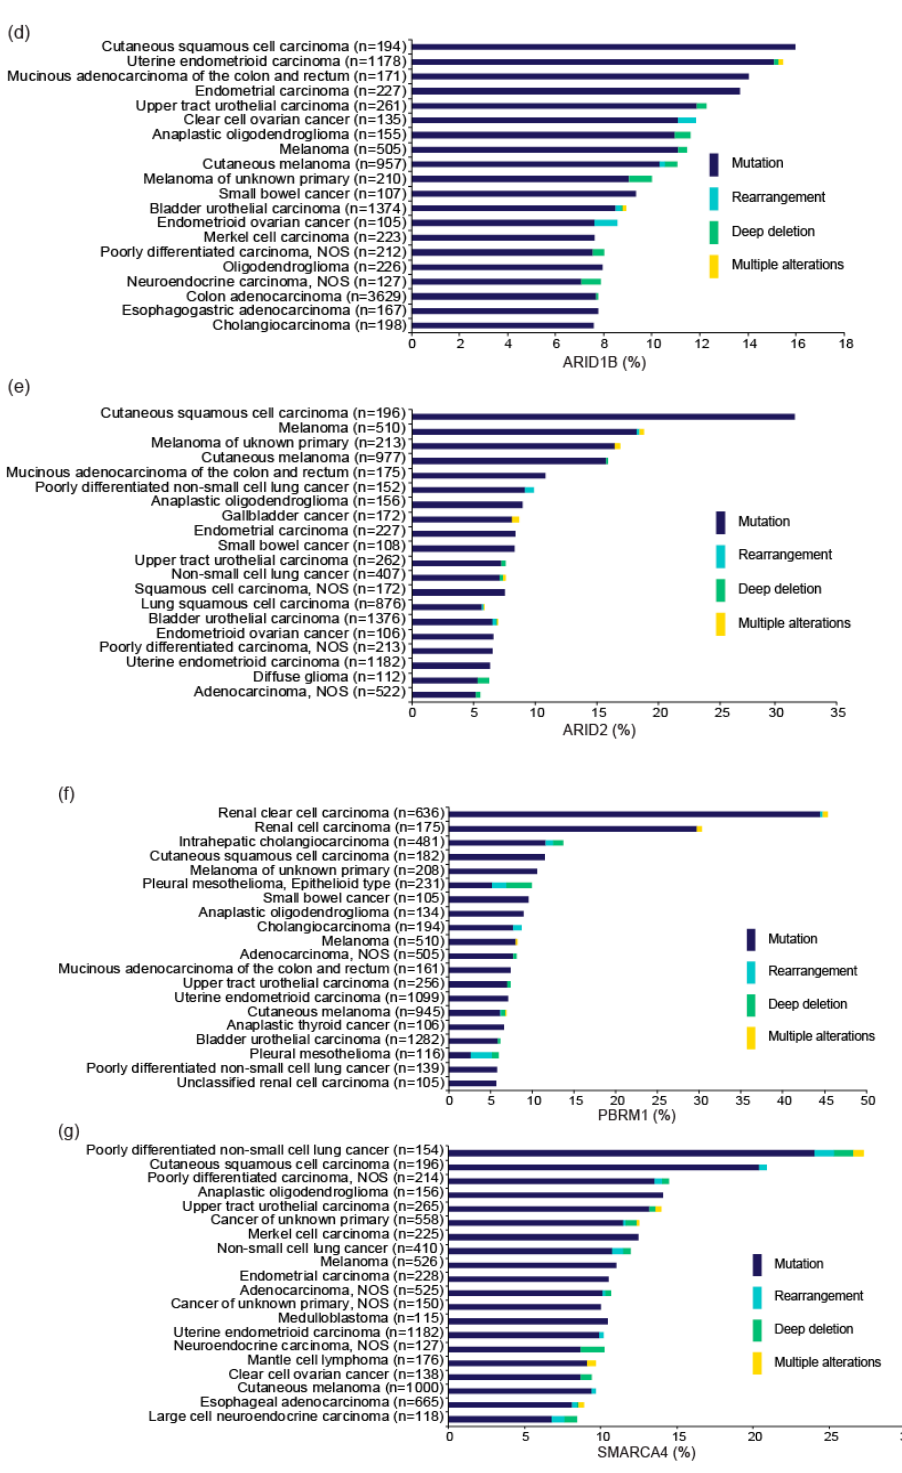
Figure 2. Mutations in genes encoding SWI/SNF chromatin remodeling factors. Mutation frequencies in OCCC ( a ) and other cancer types ( b ) in the GENIE Cohort v8.1 are shown. n: number of profiled samples. Top 20 cancer types according to mutation frequency of ARID1A ( c ), ARID1B ( d ), ARID2 ( e ), PBRM1 ( f ), and SMARCA ( g ) are shown. Cancer types detailed with >100 cases in the GENIE Cohort v8.1 are also shown. The four types of gene alteration are color-coded.